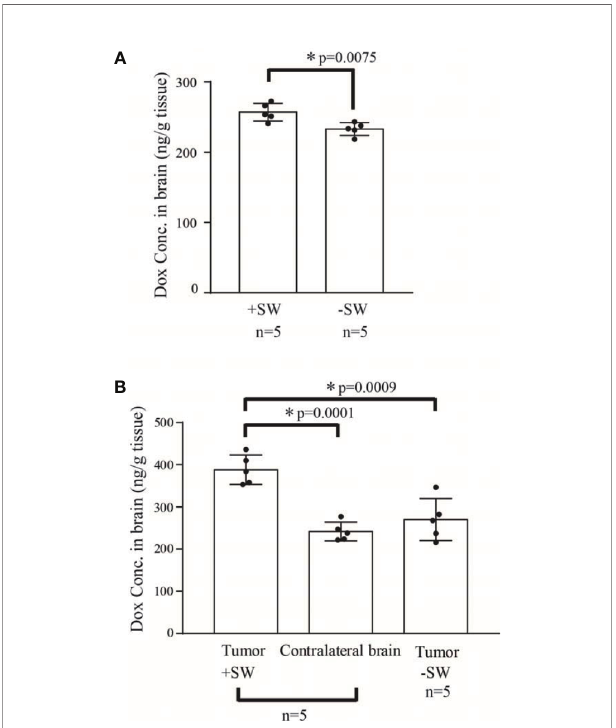
FIGURE 3 | Concentration of doxorubicin in the rat brain. (A) Concentration of doxorubicin in the normal rat brain with or without SW treatment (n = 5 for each); (B) concentration of doxorubicin in the C6 glioma-bearing brain with or without SW treatment and contralateral brain (n = 5 for each). P -value < 0.05 is considered as a signi fi cant difference between groups and summarized with an asterisk (*). SW, shockwave; Dox,